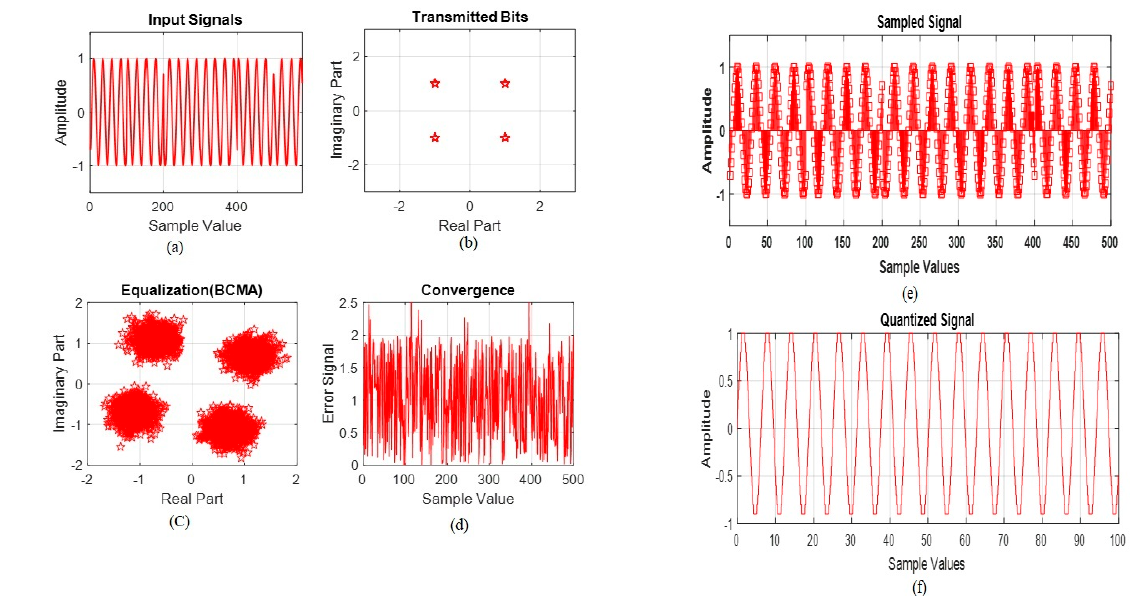
Figure 4. Trilevel preprocessing steps. ( a ) Input signal initialization; ( b ) Real part and imaginary of the input signal; ( c ) BCMA‑based equalization; ( d ) Error signal after equalization; ( e ) Sampled signal; ( f ) Result for quantization.